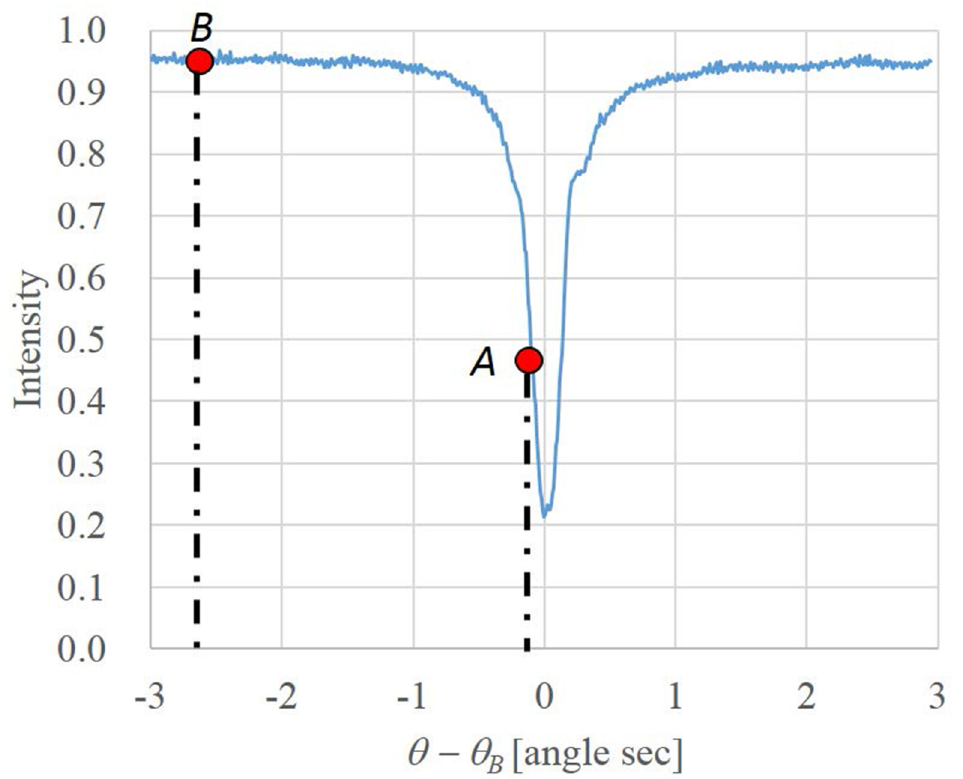
Fig 3. The rocking curve for the forward-diffraction.